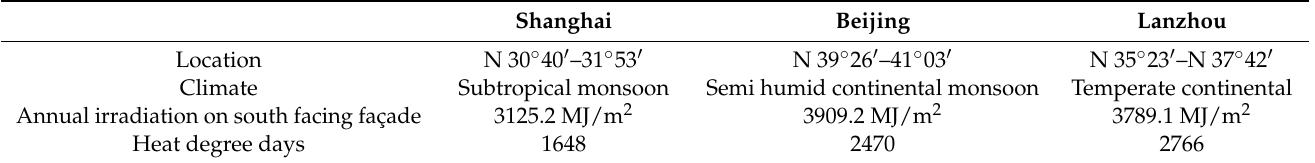
Figure 4 display the annual distribution of solar radiation on the south-facing